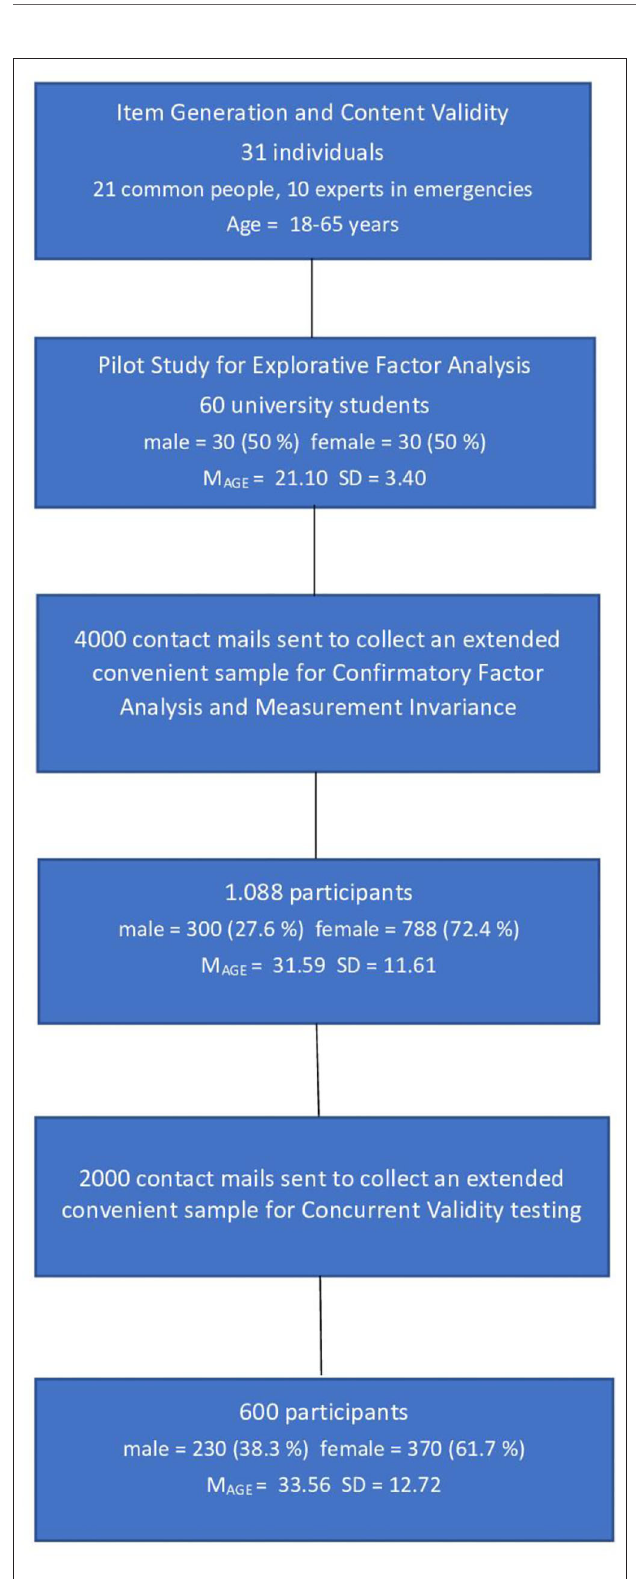
FIGURE 1 | Consort